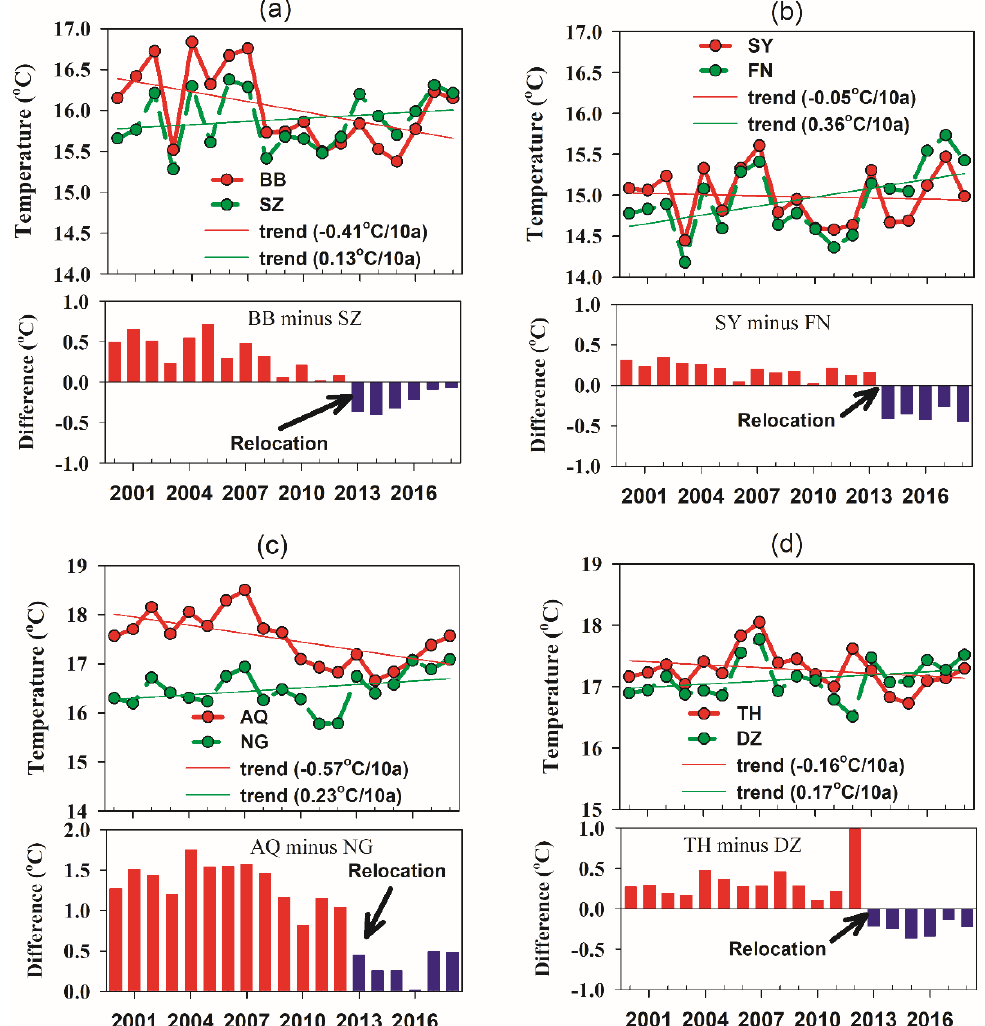
Figure 12. Time series of annual temperatures and their differences for four group stations in the YRD during 2000–2018. ( a ) BB and SZ, ( b ) SY and FN in the northern YRD; ( c ) AQ and NG, ( d ) TH and DZ in the southern YRD.